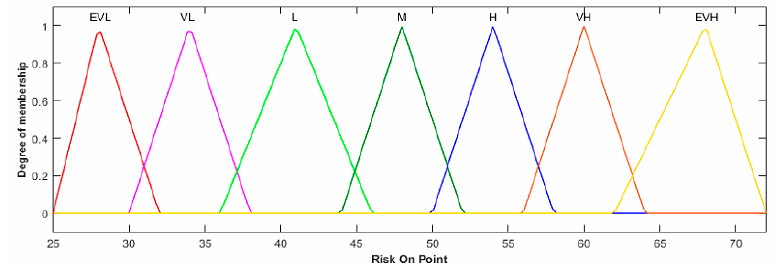
Figure 14. Output membership functions for B_FIS.